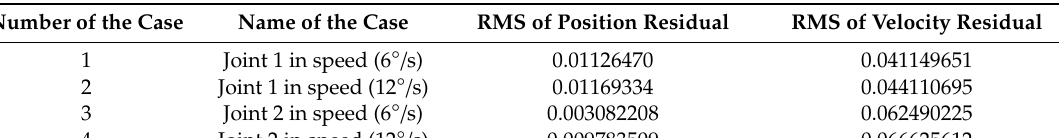
Table 6. The RMSE of both velocity residual and position residual at two speeds in joint 1 ( X -axis) and joint 2 ( Y -axis), (unit: ◦ ).